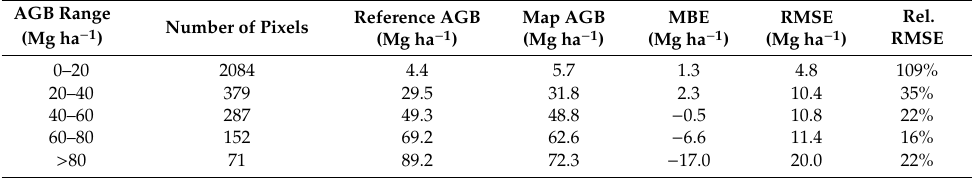
Figure 3. AGB map (30-m resolution) of the Rio Vermelho watershed in the Brazilian Cerrado, Goiás State. Zooms on the top right and bottom left of the figure show the details of the variations of the AGB between the different types of forest formations in the study area. Background image: © Bing™ aerial photo. Screenshot(s) reprinted with permission by Microsoft™ Corporation. Table 4. Cross-validation assessment by the AGB range. MBE: mean bias